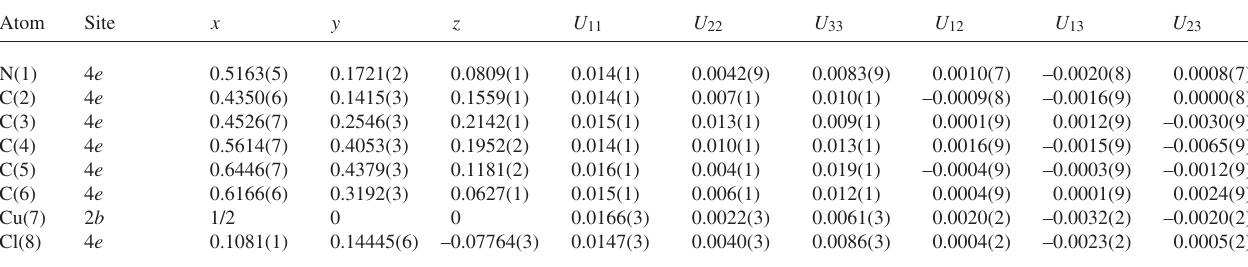
Table 3. Atomic coordinates and displacement parameters (in Å 2 )